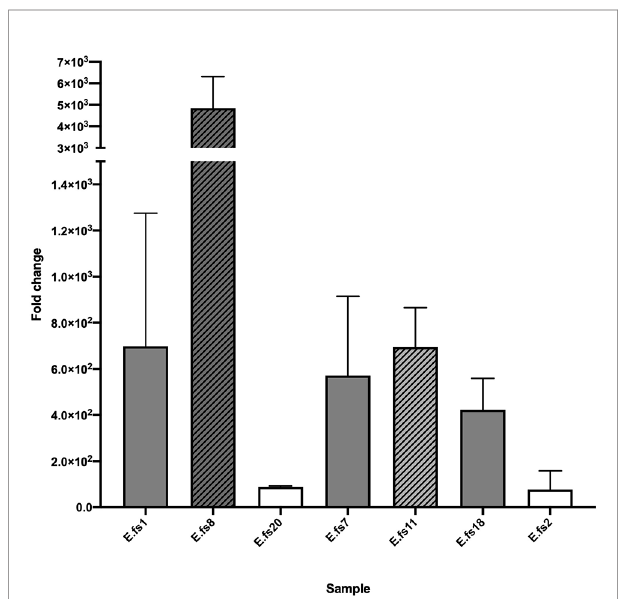
FIGURE 3 | pbp 4 gene expression analysis of the E. faecalis isolates in study, compared to that of the ATCC 47077 (OG1RF) reference. Evaluation of pbp 4 relative mRNA expression expressed as fold-change (linear). 16S rRNA gene expression levels were used as calibrator. ATCC 47077 (OG1RF) was used as reference. Error bars indicate the average of three biological replicates in three RT-qPCR assays ± SD; PSAS, white; PRAS, gray. VRE/ van A, pattern- fi lled